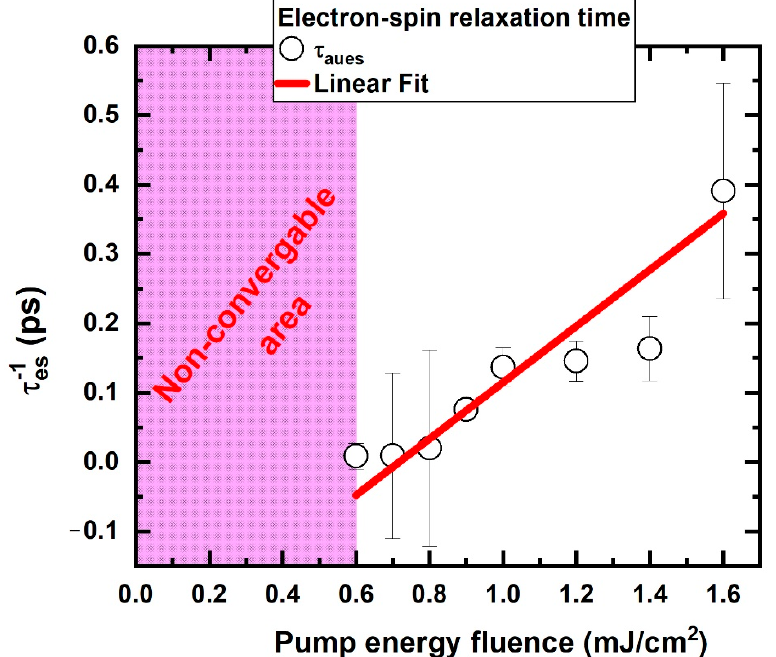
Figure 5. Dependency of the electron-spin relaxation times on the pump energy fluence, obtained from the approximation.